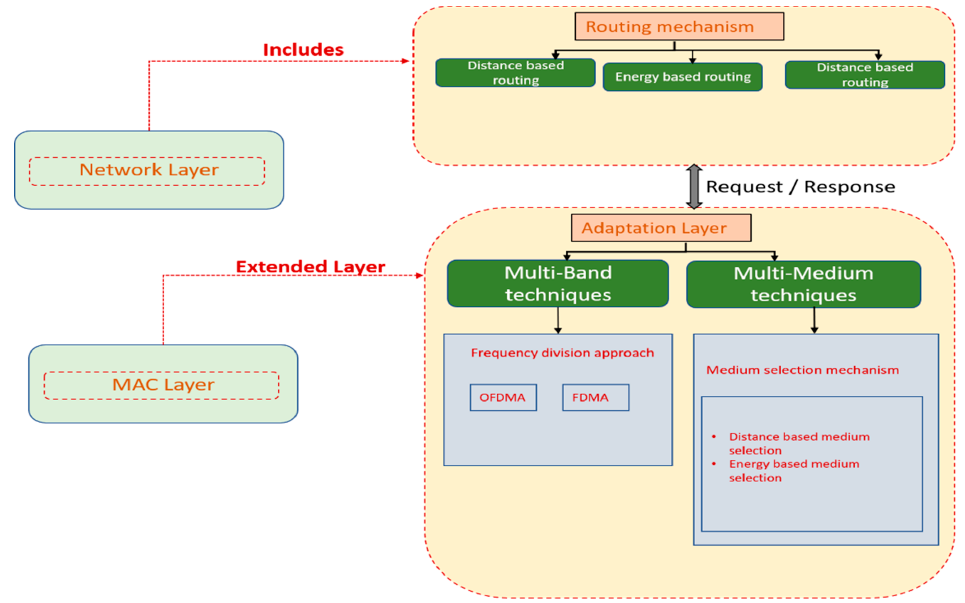
Figure 4 . MAC extension and adaptation layer.